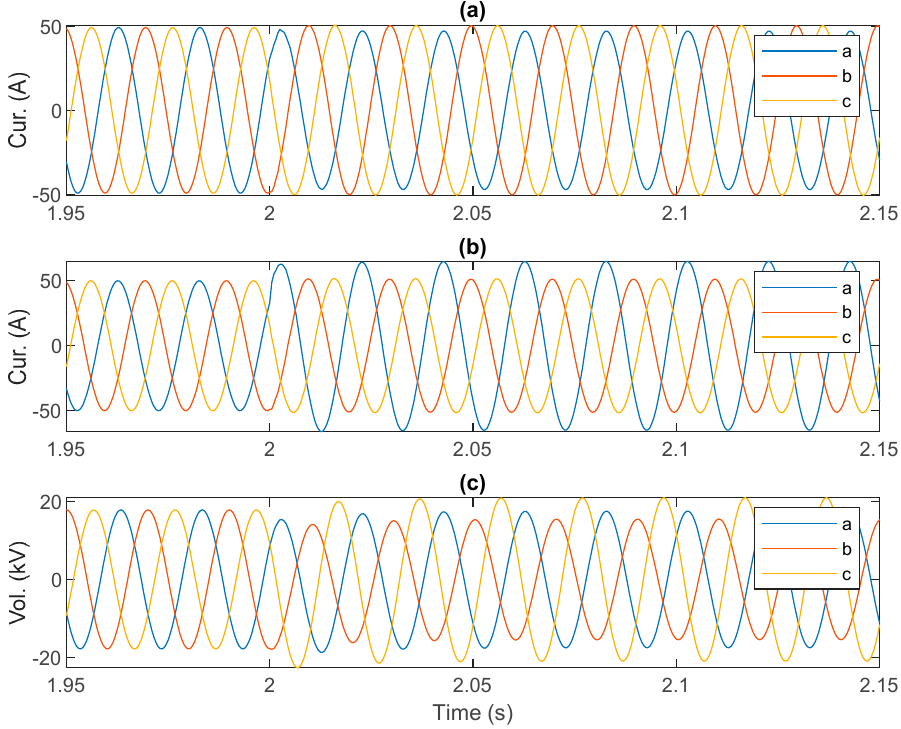
Figure 5. Simulated values during Fault 1, ( a ) phase currents at healthy feeder J06; ( b ) phase currents at faulted feeder J07; ( c ) phase to ground voltages at the primary substation.